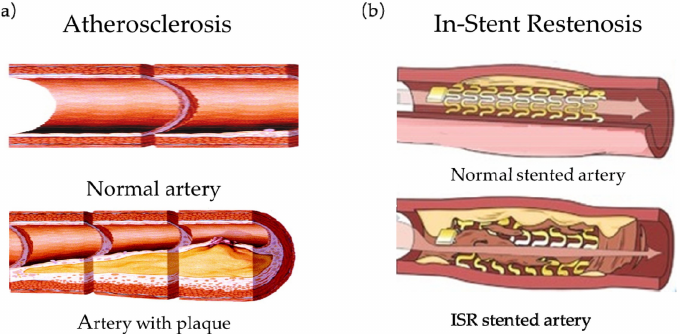
Figure 1. Atherosclerosis of blood vessels and in-stents restenosis: ( a ) Atherosclerosis [1]; ( b ) ISR [7]. At present, the causes of ISR have not been fully found and discovered. Some scholars believed that it is the result of huge changes in the geometric structure of the artery after the stent is implanted [12], and some scholars hold that the lower shear stress in the artery is also one of the reasons for restenosis [13,14]. The more important reason is that in order to ensure that the vascular stent has sufficient radial stiffness to support the inner wall of the blood vessel, Young’s modulus and hardness of the selected stent material are higher than that of the vessel. Colombo et al. elucidated the possible link between altered hemodynamics and ISR progression [15]. They found that focal re-narrowing frequently occurred after investigating from six months to 12 months. In this section, the factors triggering ISR are the following: (1) different geometry between expanded stent and blood vessel. If the stent does not match the geometry of the diseased blood vessel after expansion, a strong interaction force will generate between the stent and the inner vessel wall resulting in stress concentration [16], which damages the inner wall of the vessel and gives rise to ISR. (2) Structural stability of stent. The degree of blood vessel curvature changes with the movement of the human body, studies have demonstrated that the degree of vascular curvature of the human body is in the range of 30 ◦ to 150 ◦ , especially the degree of vascular curvature in the carotid artery position, which requires the stent to be well adapted to the geometric shape of the vascular curvature [17]. Studies have indicated that in the blood vessel with a higher degree of curvature, the stent exerted higher stress on the vessel wall and caused greater damage [18]. In a word, the stent has to keep stability after implanting. (3) Compatible mechanical properties of the stent. Due to the influence of structure and material properties, the stent has a tendency to “straighten” during the expansion process, which has a straightening effect on the diseased blood vessel. Therefore, the bending degree of the curved blood vessel would generally be significantly reduced after the stent is implanted [19–21]. Gyöngyösi et al. [19] found that before and after the stent was implanted into the aorta, the bending angle of the blood vessel was reduced from 67 ◦ to 58 ◦ , and the curvature of the blood vessel was significantly reduced. Wu et al. [21] found there were high-stress gradients and stress concentration at both ends of the stent through finite element simulation. Researchers have been looking for stents that can